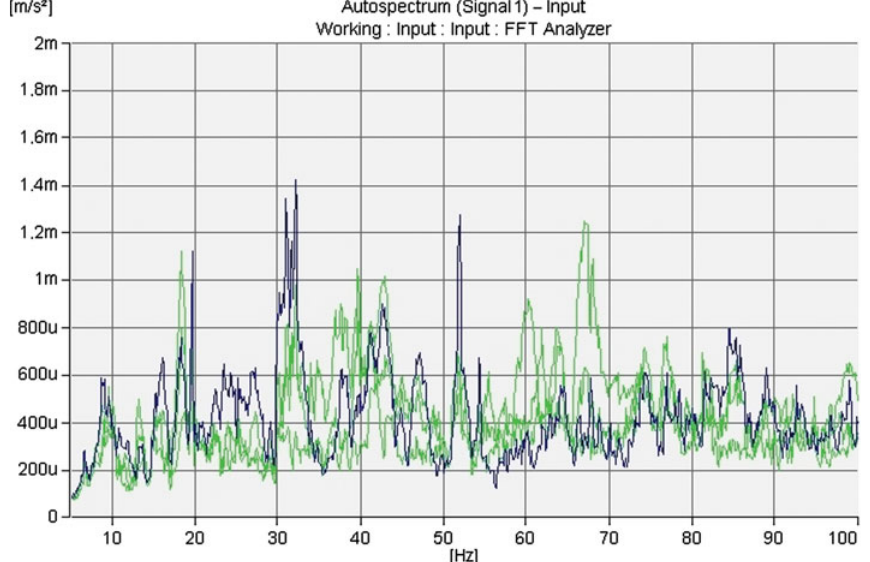
Fig. 12. Autospectrum of signals in bandwidth 5 (cid:2) 100 Hz (Signal 2 (cid:2) blue line)